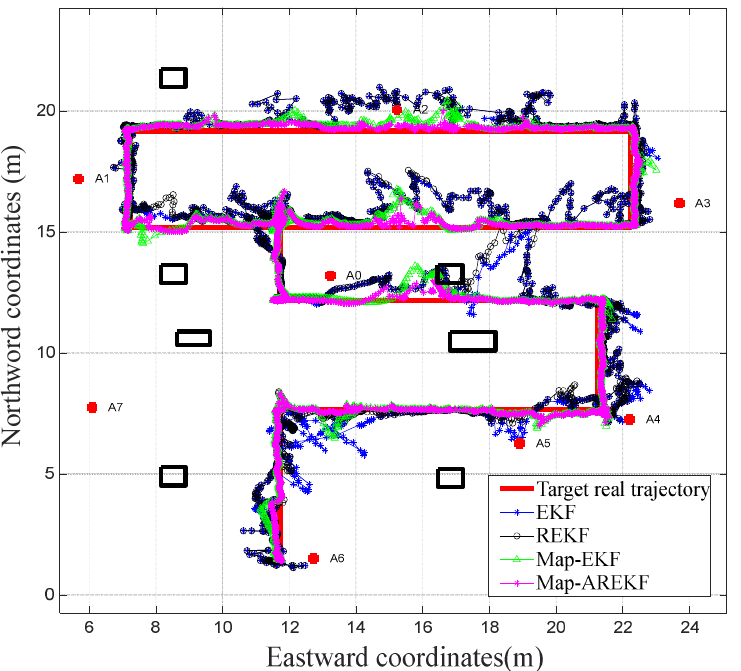
Figure 17. Comparison of the solution results of the four localization algorithms for Experiment 2.